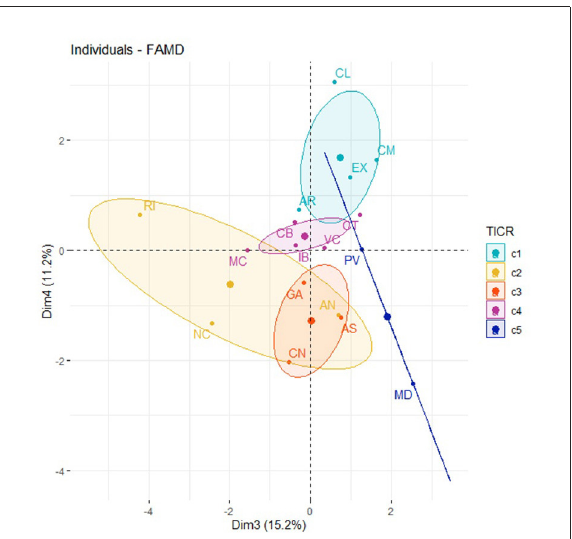
FIGURE6 Factor map of the ACS, Dimension 1, Dimension 2, and TICR.